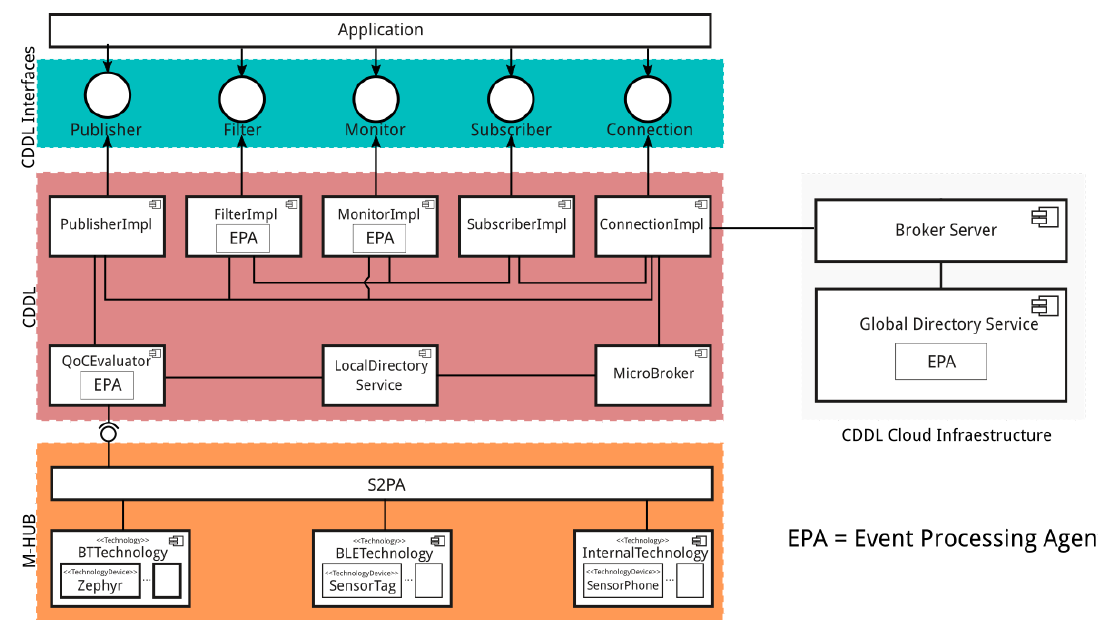
Figure 2. M-Hub/CDDL